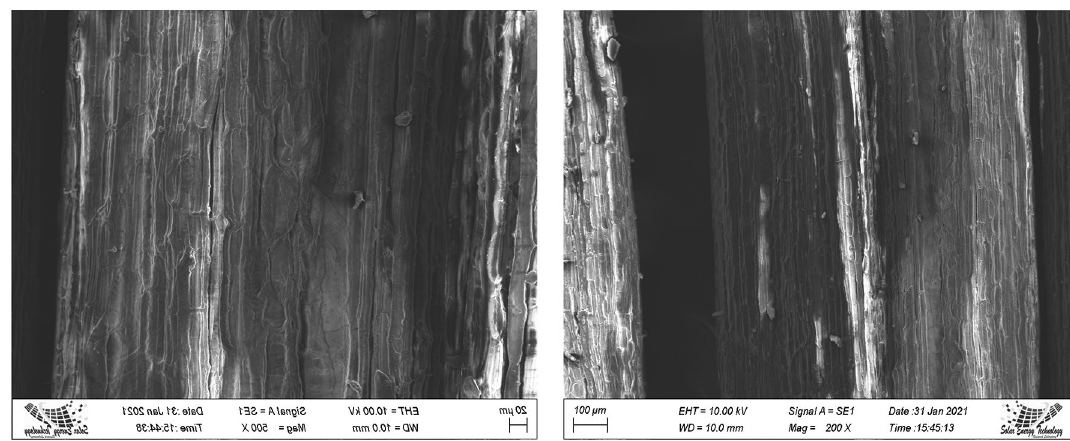
Figure 10. SEM micrographs of CTF